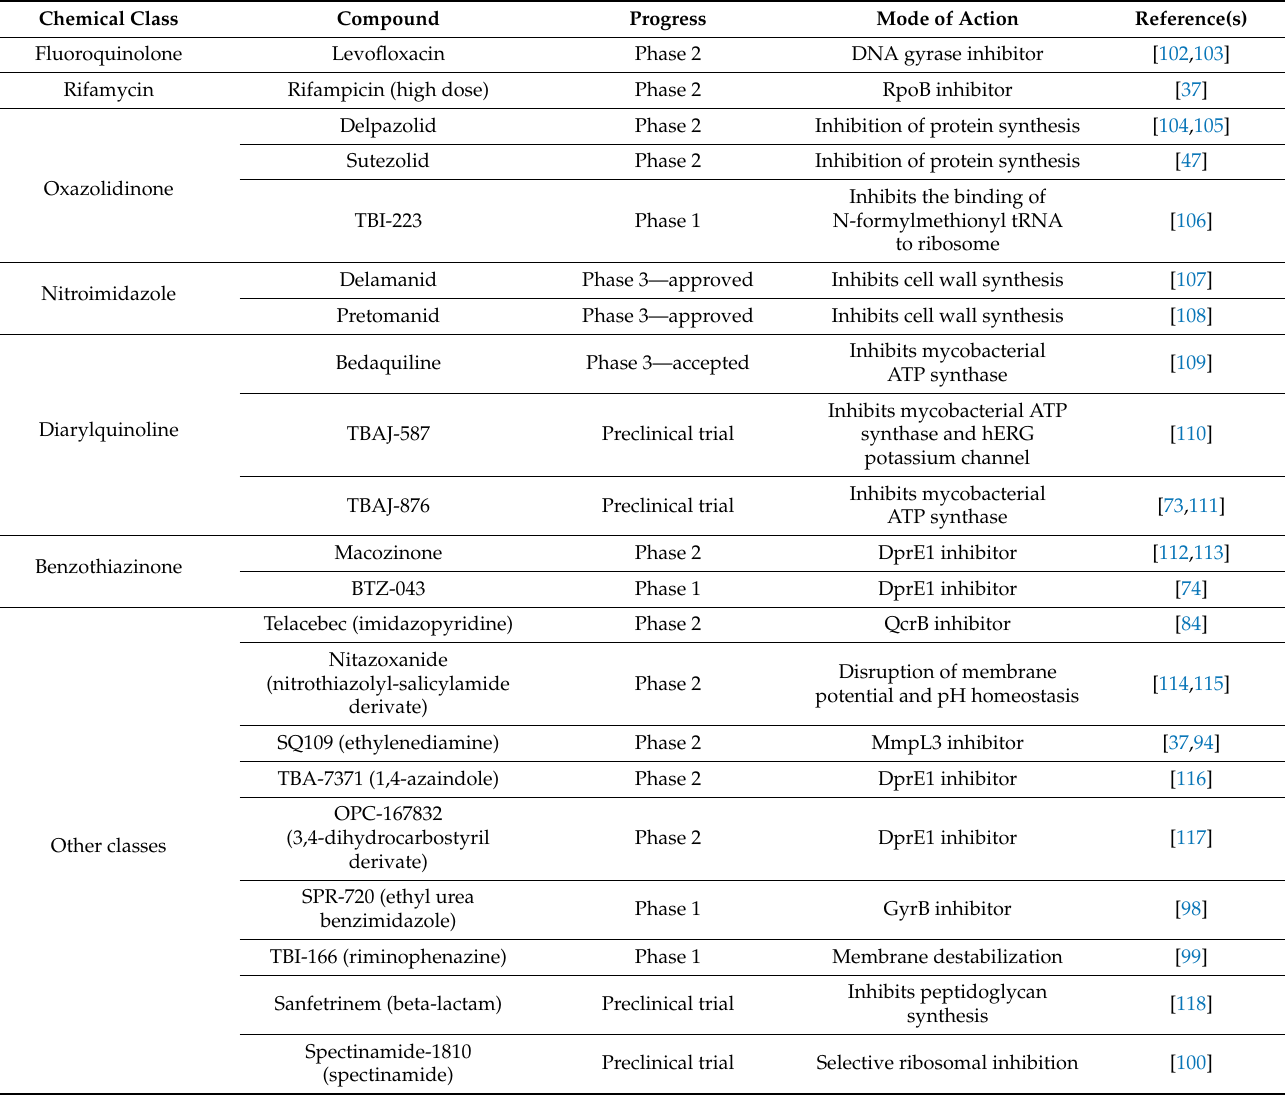
Table 1. TB drugs in clinical trials